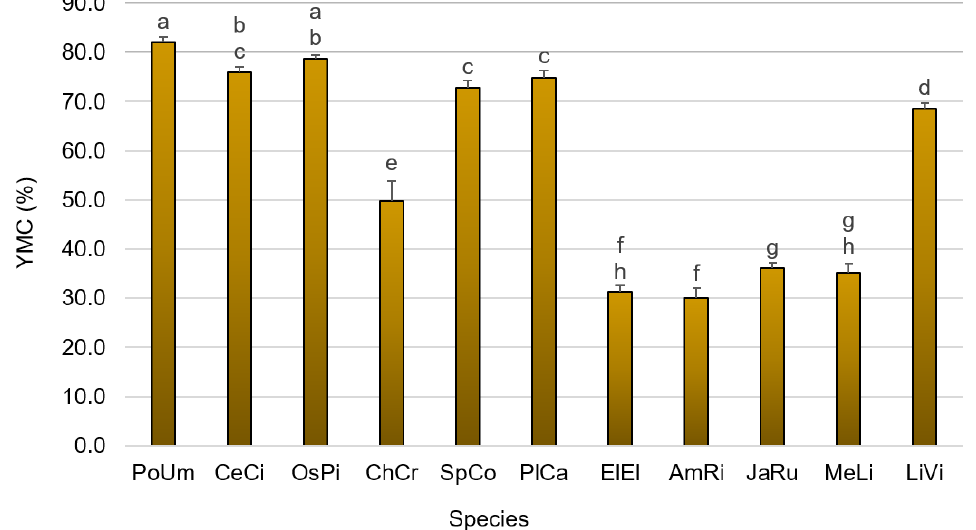
Figure 1. Yield of moisture content (YMC) of the eleven studied red seaweed species expressed in % of fresh weight. PoUm: Porphyra umbilicalis , CeCi: Ceramium ciliatum , OsPi: Osmundea pinnatifida , ChCr: Chondrus crispus , SpCo: Sphaerococcus coronopifolius , PlCa: Plocamium cartilagineum , ElEl: Elisolandia elongata , AmRi: Amphiroa rigida , JaRu: Jania rubens , MeLi: Mesophyllum lichenoides , LiVi: Liagora viscida . Values are presented as means ± SD ( n = 4), and lower-case letters ( a to h ) indicate statistically significant differences in the Tukey HSD test (F(10,43) = 580.877; p =